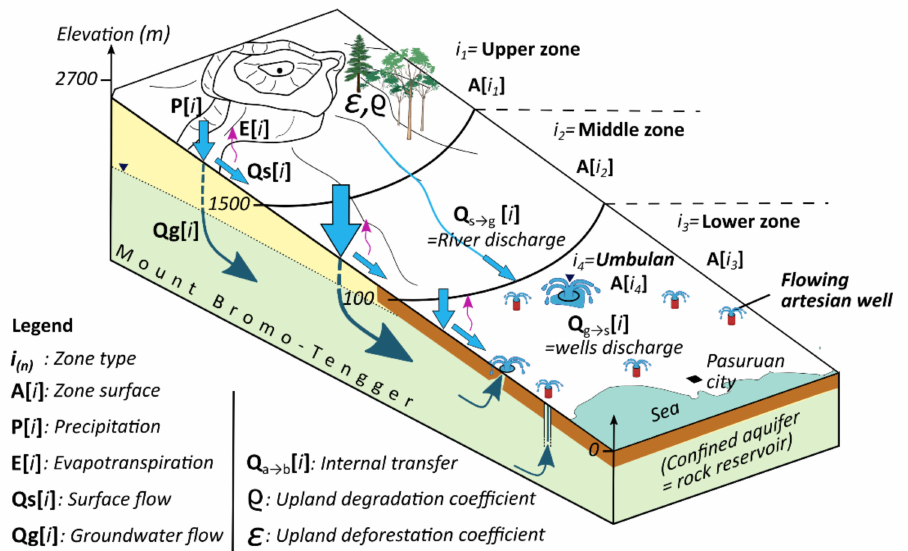
Figure 3. Simplified schema of the water balance